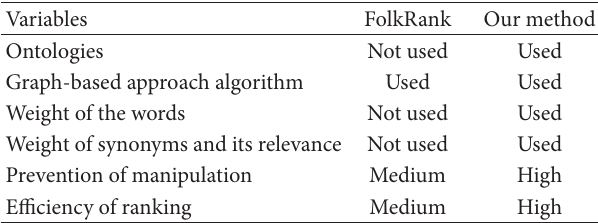
Table 5: Comparison between FolkRank and the suggested